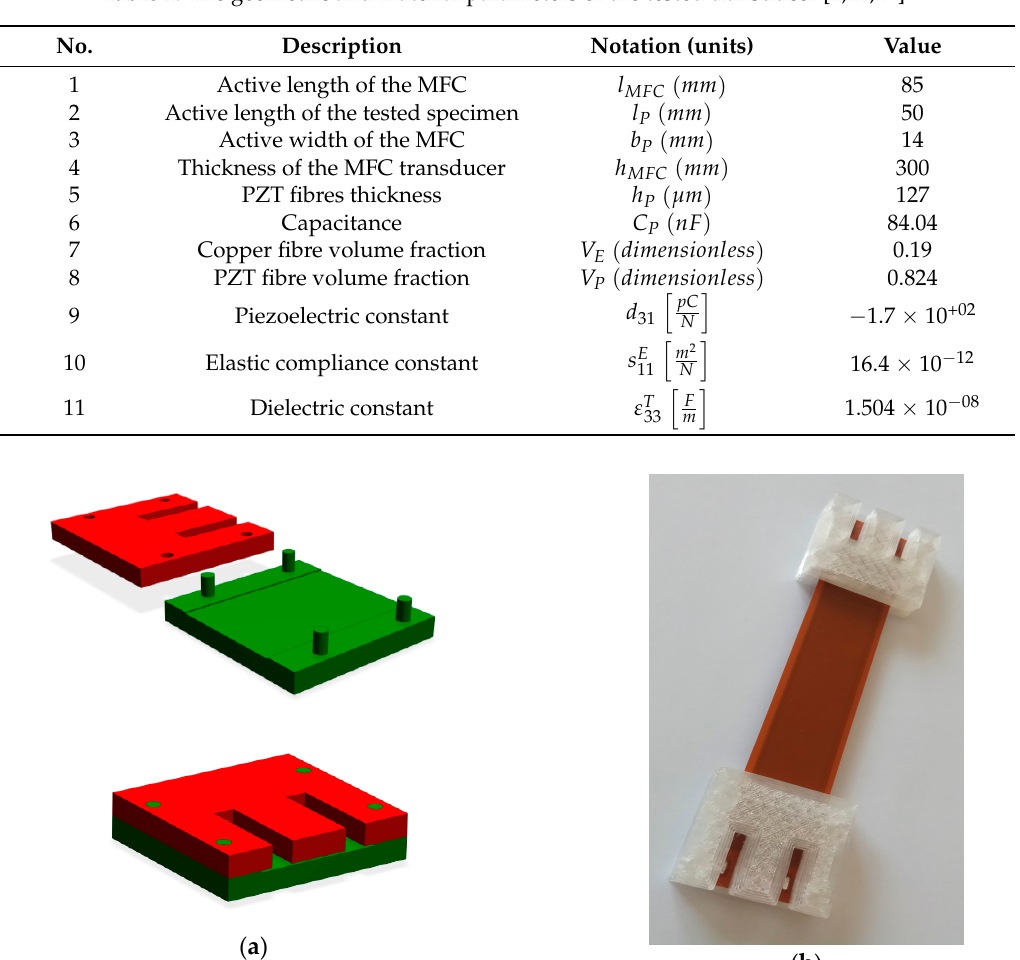
Table 1. The geometric and material parameters of the tested transducer [1,24,27].